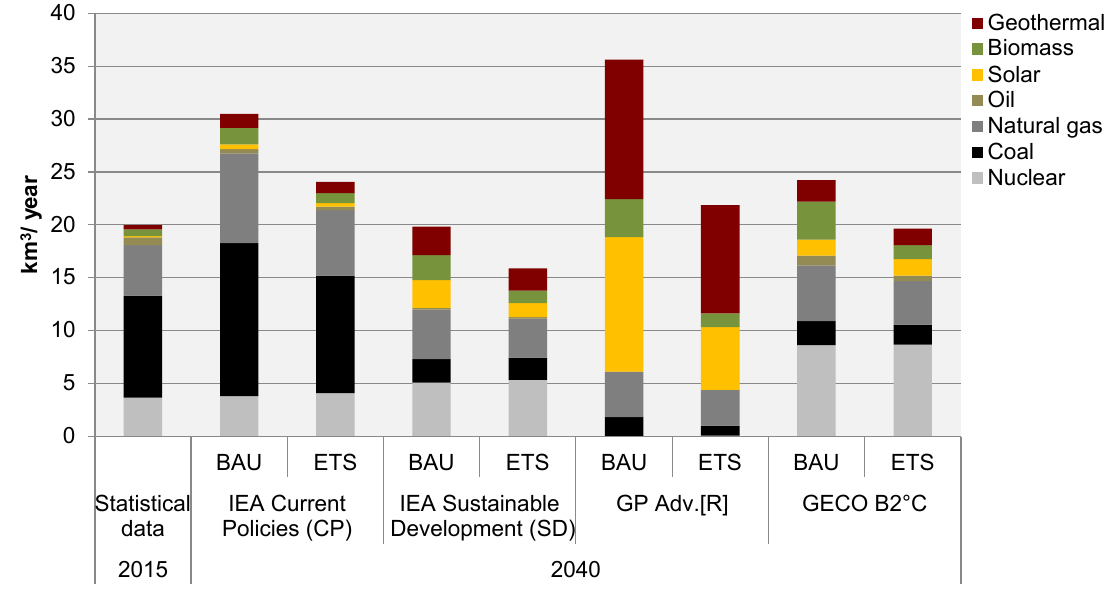
Figure 4. Water consumption (in km 3 per year without 1T-BSW) for electricity generation (km 3 ) by energy source (excluding hydropower) for the year 2015 and the four energy scenarios in combination with changes in the power plant type and cooling technologies (BAU and ETS scenarios) in 2040. (Source: own calculation based on the data from [39–41]).